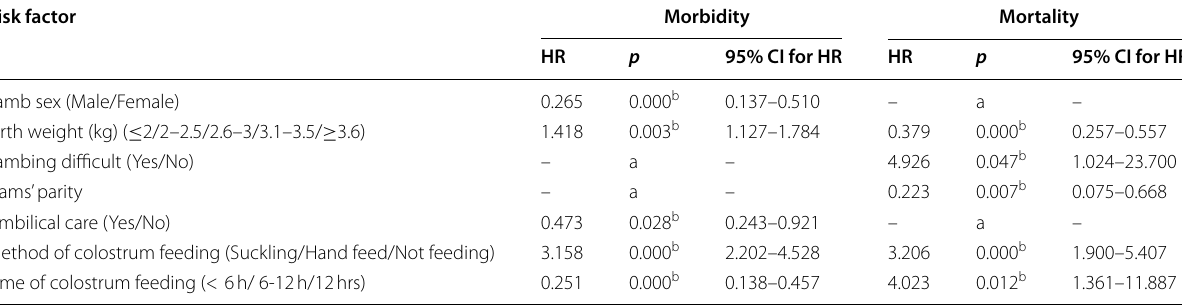
Table 6 Risk factors associated with the incidence of all-cause morbidity and mortality in lamb under three months of age in multivariable Cox proportional hazard regression model